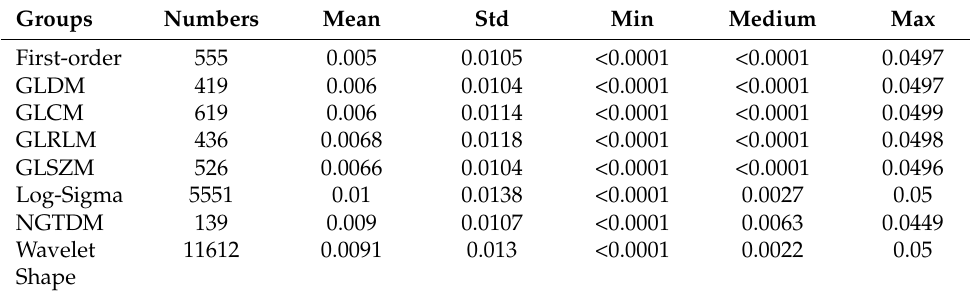
Table 5. Statistics of p -values of significant features in each radiomics group.